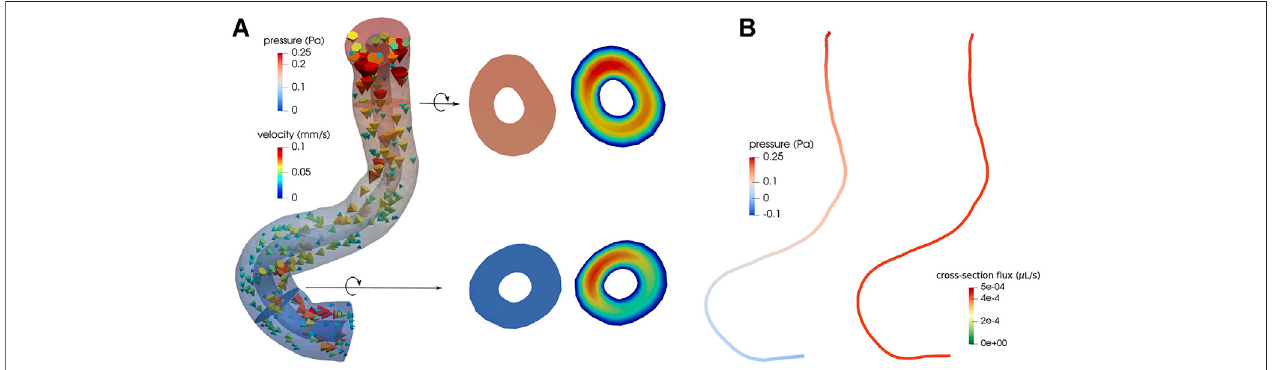
FIGURE3| Inanimage-basedperivascularsegmentwithvaryingradii,apressuredifferencebetweeninletandoutletinducesapressure fi eldthatisnearlyconstant oneachcross-section,butavelocity fi eldthatvarieswiththeradial,angularandaxialcoordinates. (A) Fullpressureandvelocityapproximationsinthedomain(left)along with close-up views of the pressure (middle) and velocity magnitude (right) at two cross-sections; (B) Reduced average cross-section pressure (left) and cross-section fl ux approximations